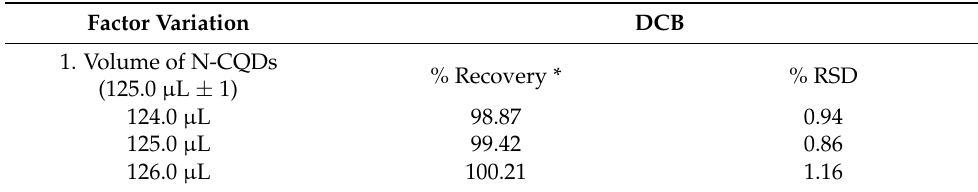
Table 4. Evaluation of the robustness of the proposed